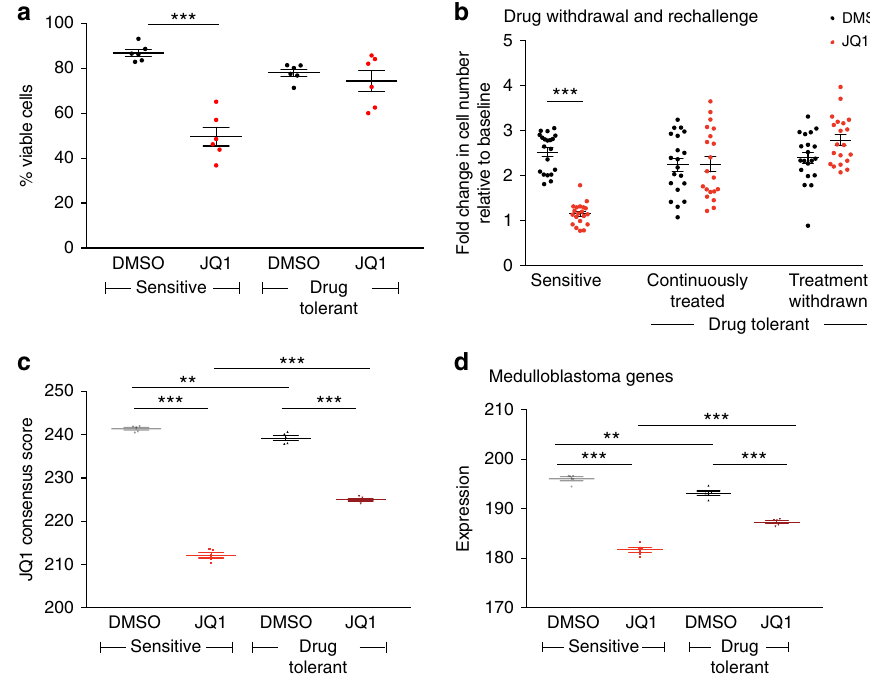
Fig. 4 Drug-tolerant cells exhibit attenuated responses to BETi. a Percentage of viable cells among sensitive and drug-tolerant D425 and D458 populations after 72 h of treatment with JQ1. Error bars depict mean across six independent experiments ± SEM. *** p < 0.001 as determined by two-tailed unpaired t -tests. Source data: Source Data File. b Fold change in cell proliferation relative to pre-treatment baseline following 48 h of treatment with JQ1 among sensitive and drug-tolerant D425 and D458 cells that had been maintained in continuous JQ1 treatment ( “ drug-tolerant continuously treated ” ) or in which JQ1 had been withdrawn for 30 days ( “ drug-tolerant treatment withdrawn ” ). Data depict 20 replicate measurements across 4 independent experiments; error bars depict mean ± SEM. Asterisks (***) depicts p < 0.0001 as determined by two-tailed unpaired t -test. Source data: Source Data File. c Expression of genes in the JQ1 consensus signature in sensitive and drug-tolerant D458 cells following 24 h of treatment with JQ1 (1 μ M) or vehicle control. Data from fi ve independent replicates are shown, error bars depict mean ± SEM. Asterisks denote signi fi cant differences (* p < 0.05, ** p < 0.01, *** p < 0.001) as determined by two-tailed unpaired t -tests. Source data: Source Data File. d Expression of JQ1 medulloblastoma target genes in sensitive and drug-tolerant cells treated with JQ1 or vehicle control. Values represent mean of fi ve replicate experiments ± SEM. Asterisks denote signi fi cant differences (* p < 0.05, ** p < 0.01, *** p < 0.001) as determined by two-tailed unpaired t -tests. Source data: Source Data File